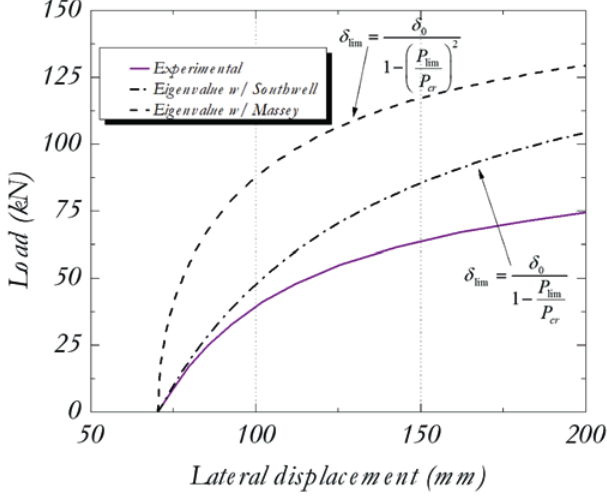
Load-lateral displacement response for aligned pads